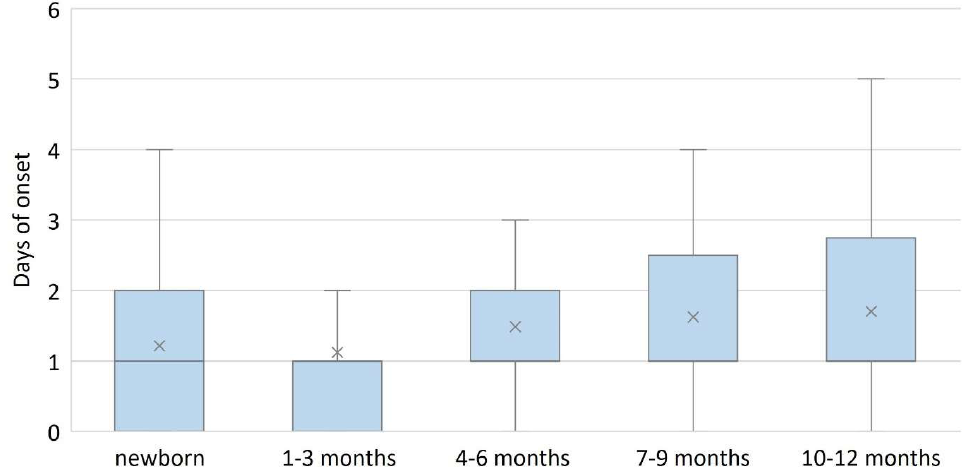
Figure 2. Number of days of onset of symptoms according to age group. Infants between 1–3 months presented to the hospital earliest after the onset of symptoms. In contrast, infants between 9–12 months presented the latest. Box and whiskers plot represent the 25 th and 75 th percentiles (box), the median (×) and the range (whiskers).